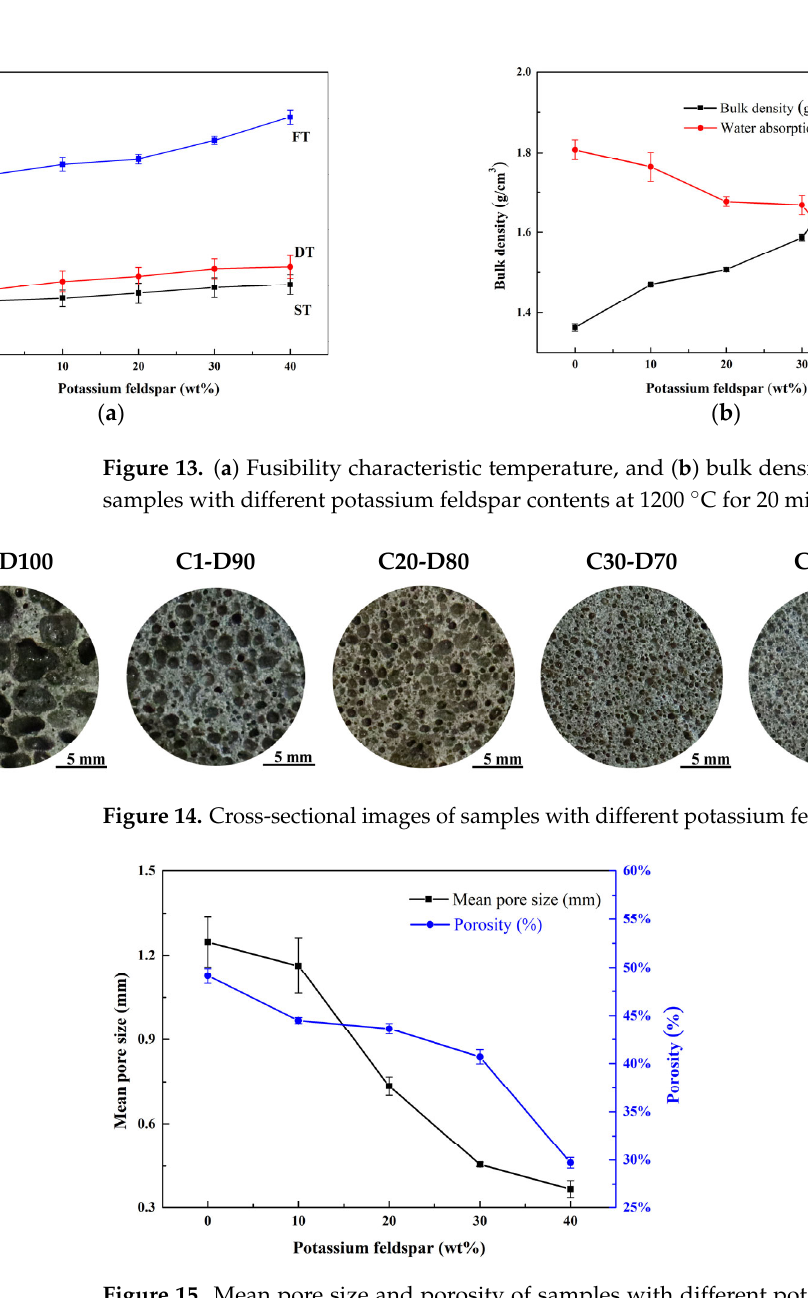
Figure 15. Mean pore size and porosity of samples with different potassium feldspar contents at 1200 ◦ C for 20